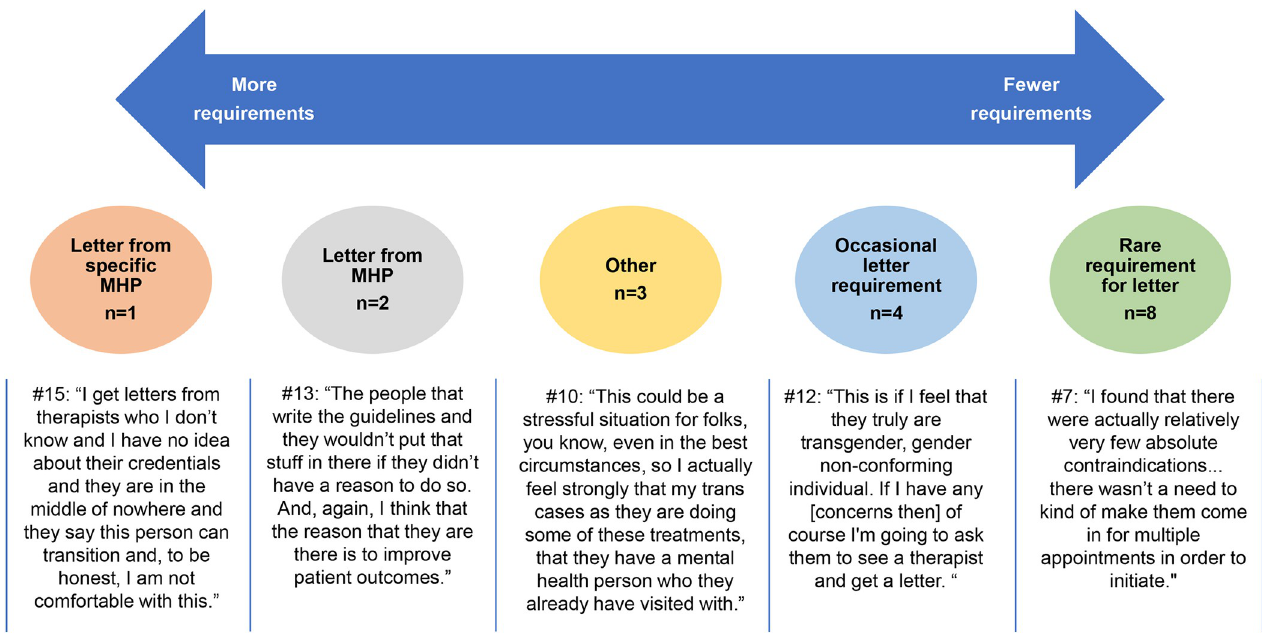
Fig 1. Providers’ perspectives on the role of a mental health provider. MHP, mental health